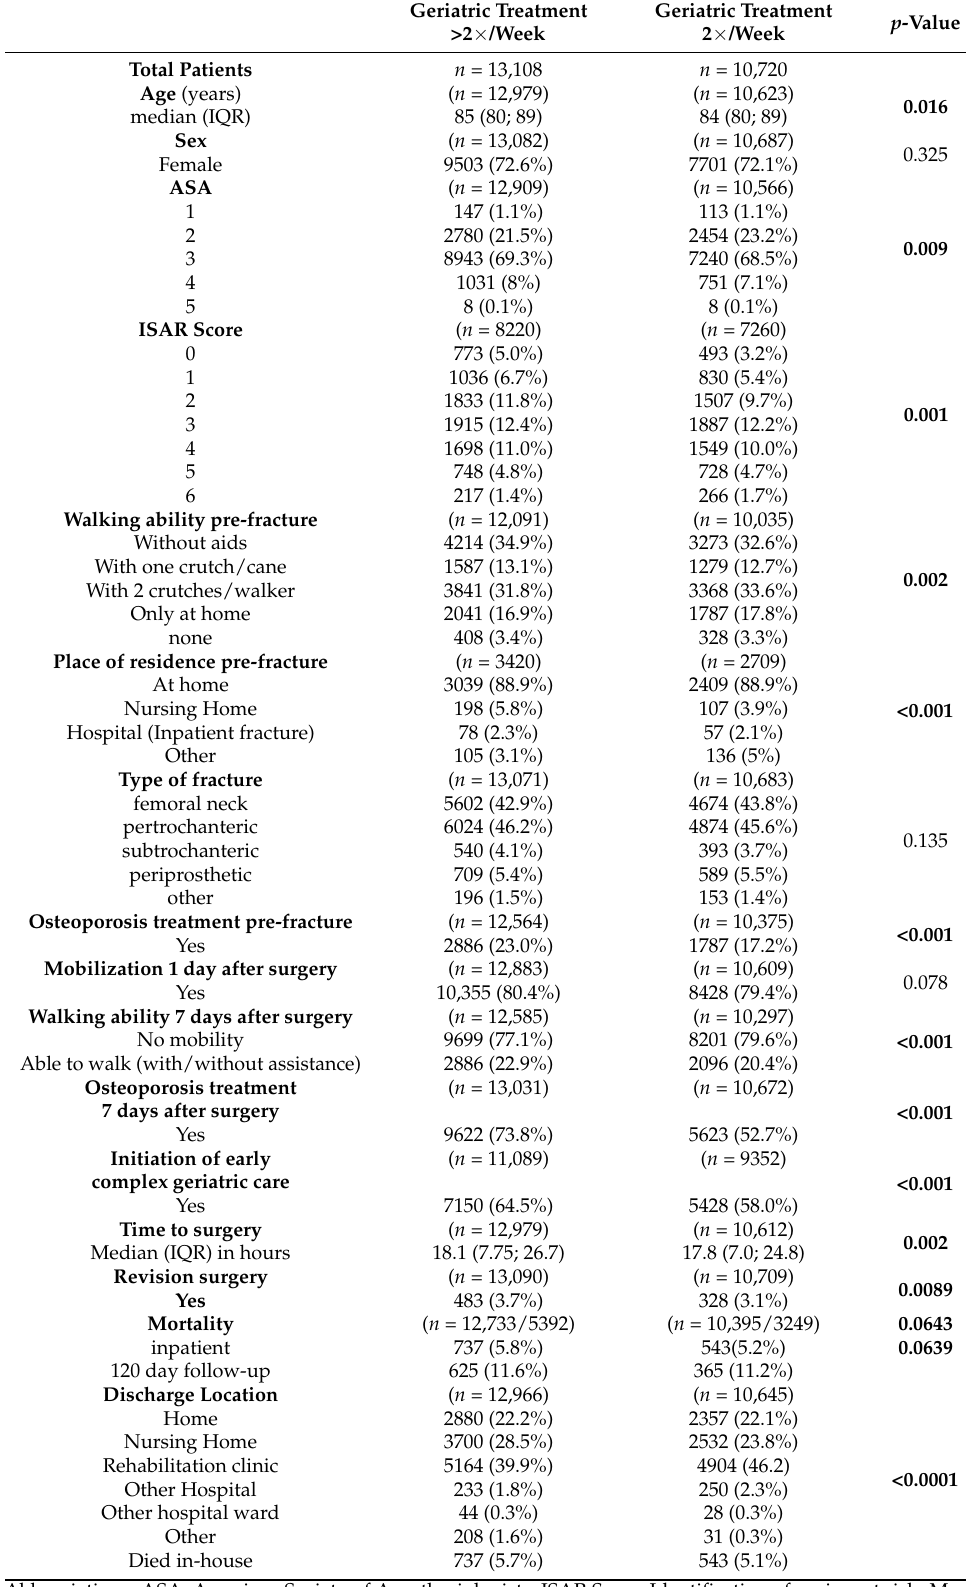
Table 1. Baseline characteristics of older adults with geriatric treatment more than two times/two times per week following hip fracture